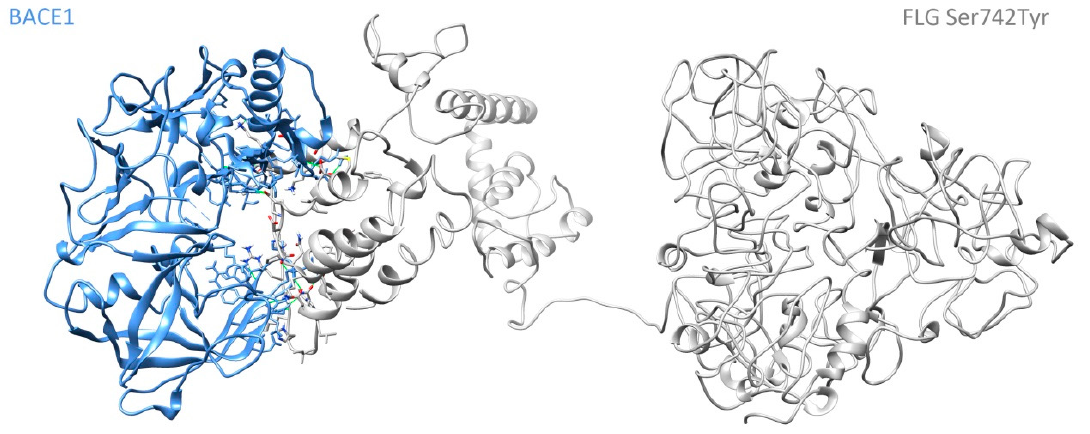
Figure 2. Three-dimensional protein structure of the complex BACE1-FLG